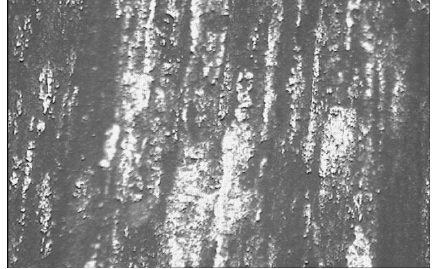
Figure 4 (b) Mild steel sample kept in 1 M HCl for 24 hours with 250 ppm SLS at 35 0